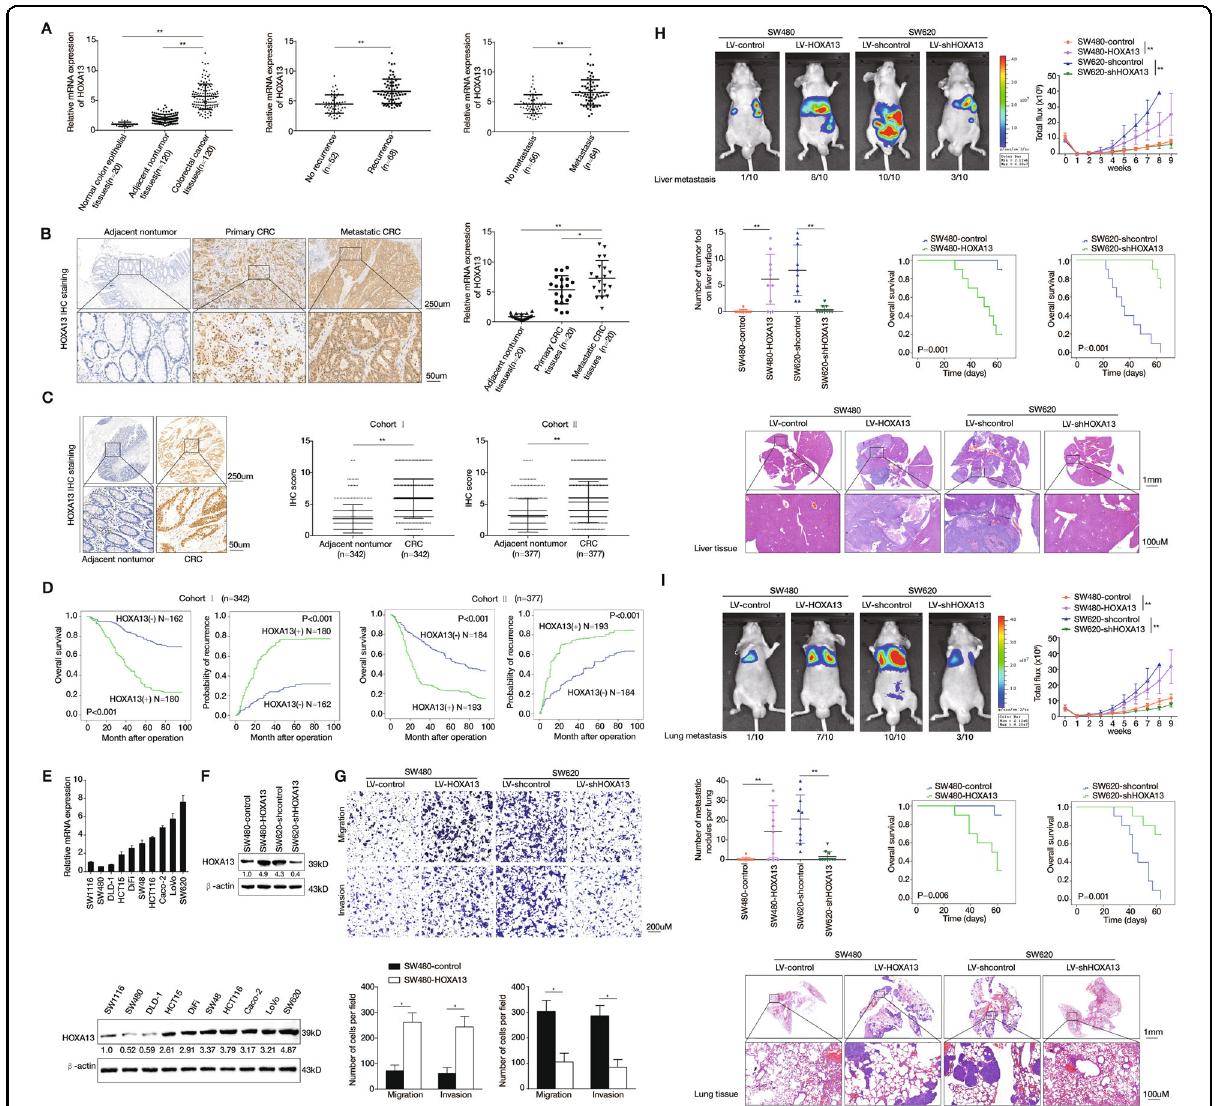
Fig. 1 Overexpression of HOXA13 promotes CRC metastasis and indicates worse prognosis. A (Left) Real-time PCR analysis of HOXA13 expression in 120 pairs of CRC and adjacent nontumor specimens, and normal colorectal epithelial specimens ( n = 20). (Middle) The mRNA expression of HOXA13 in CRC specimens from patients with recurrence ( n = 52) or without recurrence ( n = 68). (Right) The mRNA expression of HOXA13 in CRC specimens from patients with metastasis ( n = 56) or without metastasis ( n = 64). B The protein and mRNA expression of HOXA13 were detected by IHC staining (left) and real-time PCR (right) analyses in 20 pairs of normal colorectal epithelial tissues, primary colon cancer, and paired metastatic CRC tissues. The scale bars represent 250 μ m (low magni fi cation) and 50 μ m (high magni fi cation). C (Left)The representative image of IHC staining of HOXA13 in CRC and adjacent nontumor tissues microarray. The scale bars represent 250 μ m (low magni fi cation) and 50 μ m (high magni fi cation). (Right) The IHC score of HOXA13 in CRC and adjacent nontumor samples in two independent cohorts. D Kaplan – Meier analysis of the relationships of HOXA13 expression and overall survival times or the recurrence rates in two independent CRC cohorts. E Real-time PCR (upper) and western blotting (lower) analyses of the mRNA and protein expression of HOXA13 in CRC cell lines. F Western blotting (lower) analysis of HOXA13 protein expression in SW480 and SW620 cells after lentivirus transfection. G Cell migratory and invasive capabilities in the indicated CRC cell lines by Transwell assay. H In vivo liver metastatic assays. Four stable cell lines were injected into the spleens of nude mice ( n = 10 mice per group). Representative bioluminescent imaging, intensity of bioluminescence signals, number of metastatic liver nodules, overall survival times, liver tissues ’ HE staining in each group ( n = 10), and the incidence of liver metastasis were shown. The scale bars represent 1 mm (low magni fi cation) and 100 μ m (high magni fi cation). I In vivo lung metastatic assays. Four stable cell lines were injected into the tail veins of nude mice ( n = 10 mice per group). Representative bioluminescent imaging, intensity of bioluminescence signals, number of metastatic lung nodules, overall survival times, lung tissues ’ HE staining in each group and the incidence of lung metastasis were shown. The scale bars represent 1 mm (low magni fi cation) and 100 μ m (high magni fi cation). * P < 0.05 ** P < 0.01. Data are displayed as the mean ±